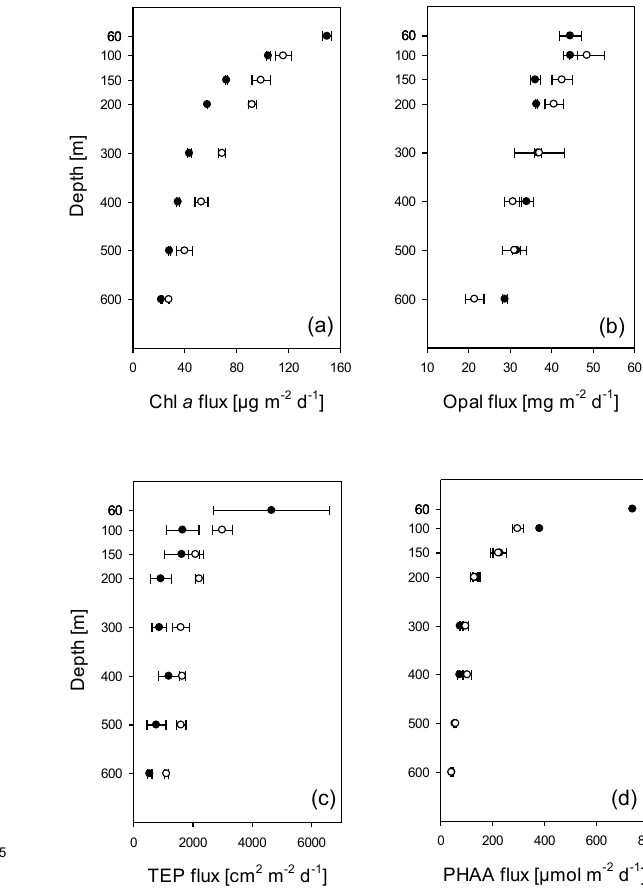
Figure 3. Fluxes of (a) chlorophyll a (Chl a ), (b) opal, (c) TEP and (d) PHAA during the deployment of two STDT in the ETNA. Solid symbols are used for deployment no. 1 and open symbols for deployment no.